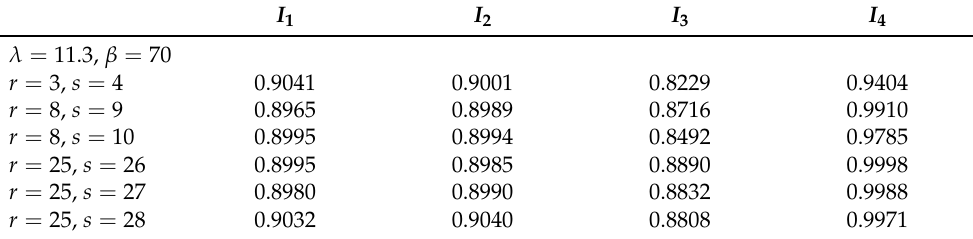
Table 2. Percentages of coverage of the 90% prediction intervals I 1 , . . . , I 4 for the s th lower